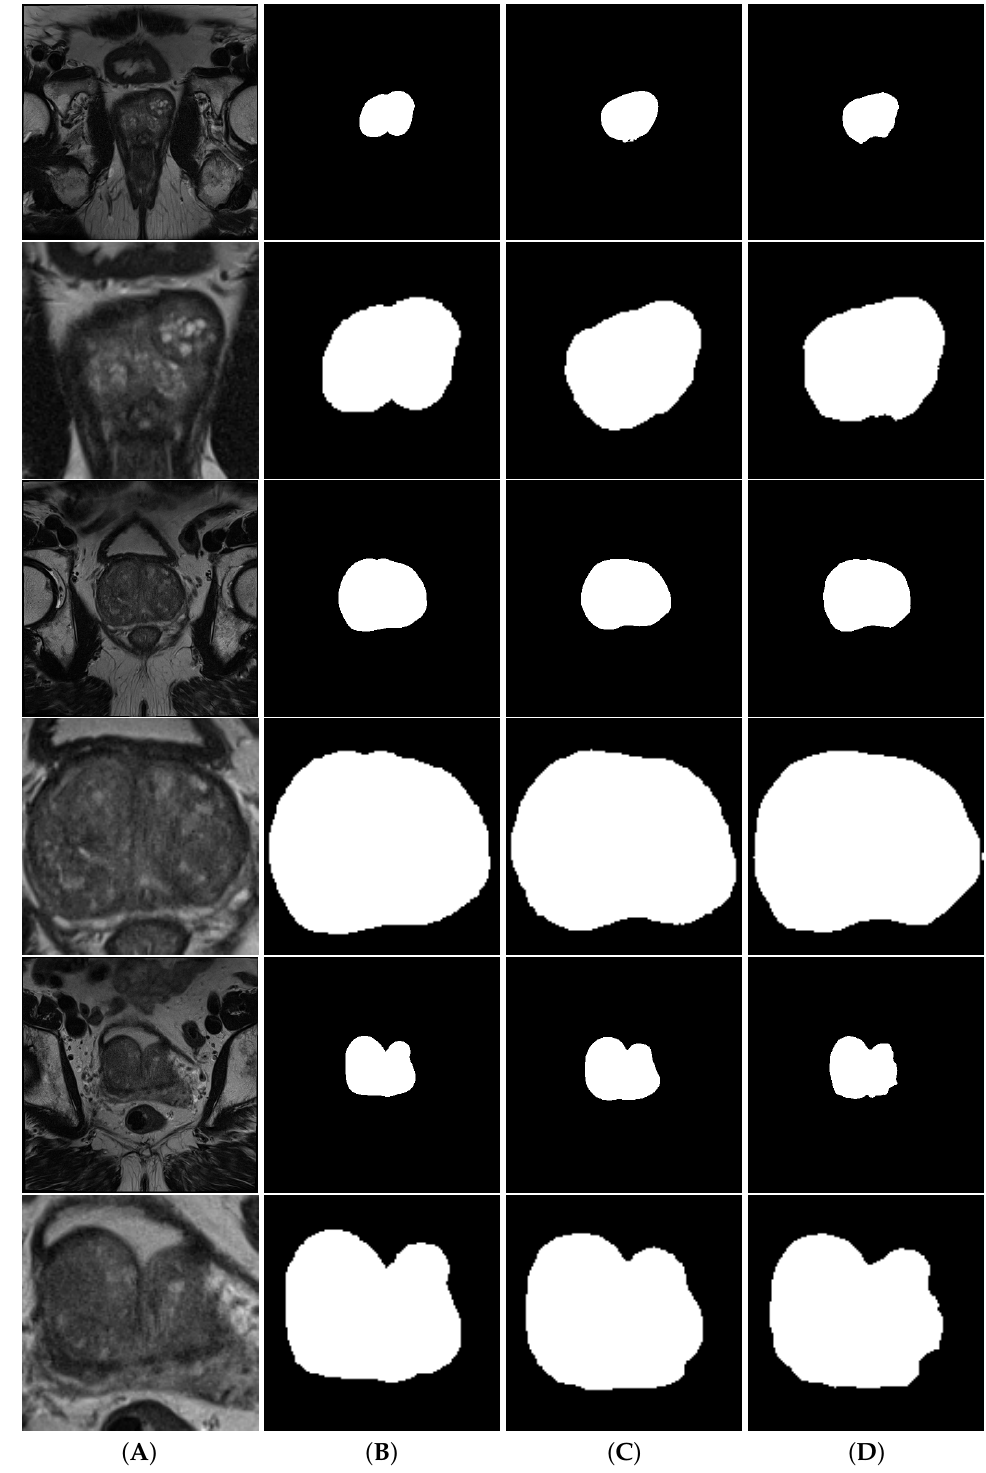
Figure 5. Segmentations of the prostate gland. Column ( A ) contains the volumes, column ( B ) contains the ground truth, column ( C ) contains the nnU-Net segmentations and column ( D ) contains the d2aunet segmentations. Rows are interleaved, showing a full volume and a model cropped by the object detection model,